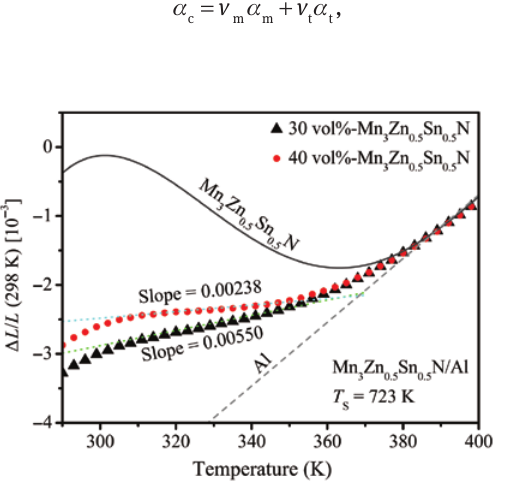
Zn Sn N/Al composites 3 0.5 0.5